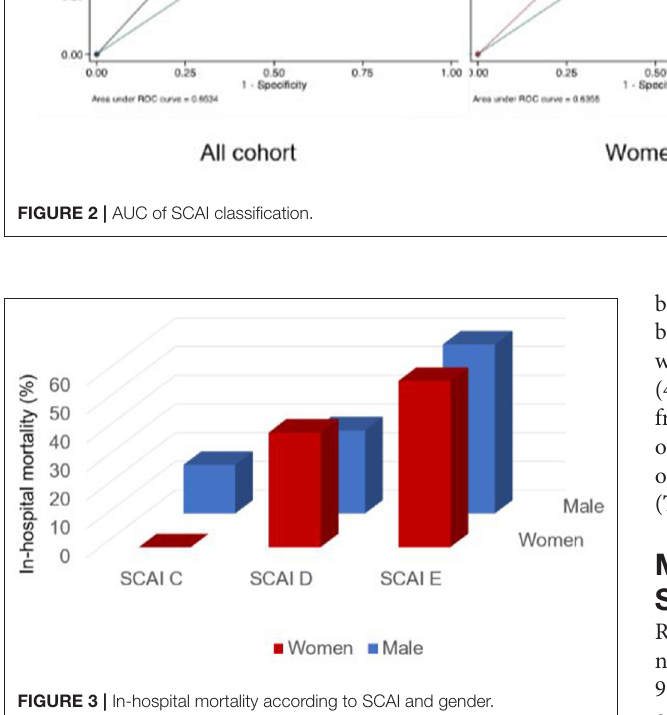
FIGURE 3 | In-hospital mortality according to SCAI and